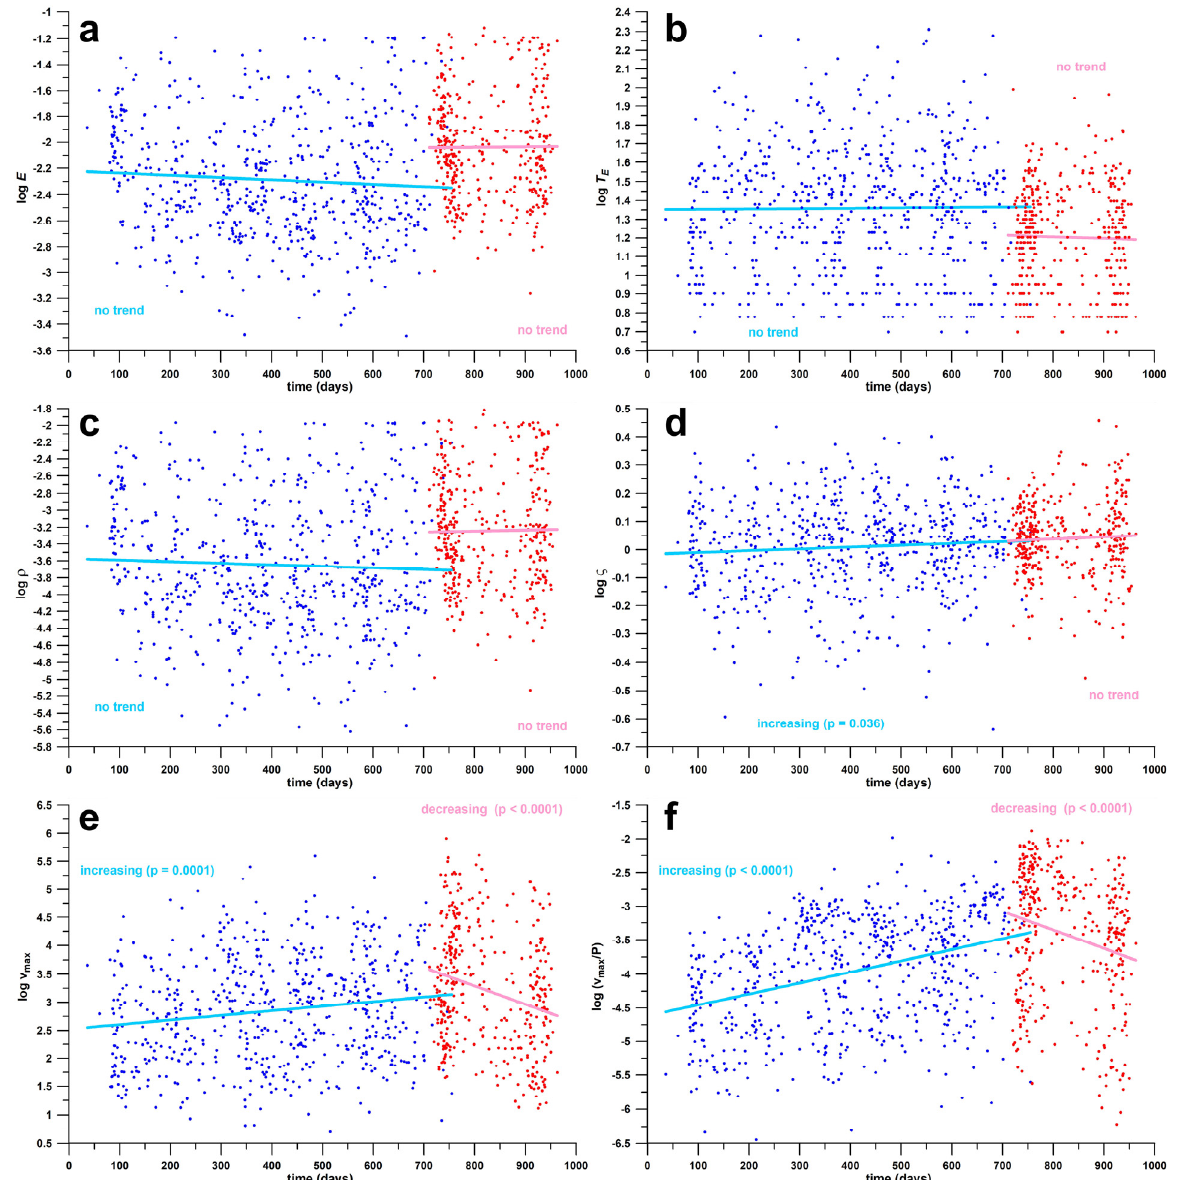
Figure 7. Regressions; ( a ) effectiveness E data of 615 pre-Omicron (blue) and 385 Omicron (red) waves against time; ( b ) duration of the effective phase T E against time; ( c ) ρ against time; ( d ) log ς against time; ( e ) peak velocity v max against time; ( f ) peak velocity per population ( v max /P) against time; “no trend” refers to p > 0.05.